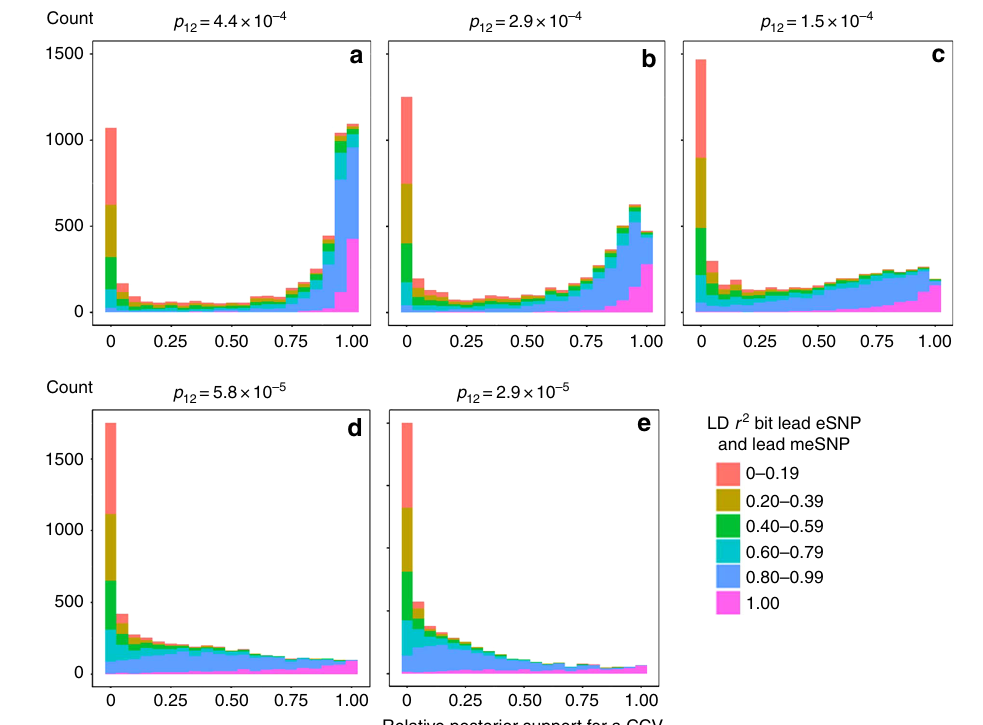
Fig. 2 Histogram of the relative posterior support for a CCV strati fi ed by strength of LD (r 2 ) between the lead eSNP and lead meSNP. The relative posterior support for a CCV is de fi ned as the posterior probability of a CCV divided by the sum of the posterior probabilities for a CCV and for distinct causal variants (DCV). These data are restricted to co-localization tests for which the sum of the posterior probabilities for DCVand CCV are >0.8 (100 out of 5397 tests excluded). Results are shown for fi ve values of the prior p 12 (panels a - e